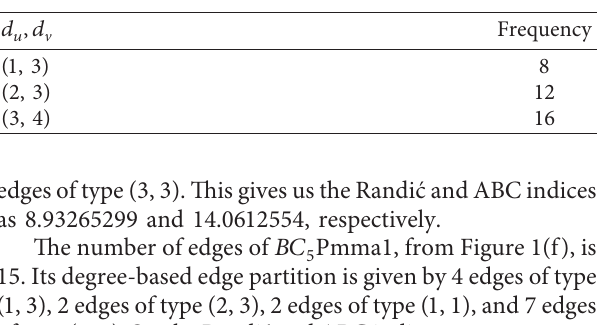
Table 1: Edge partition of BC